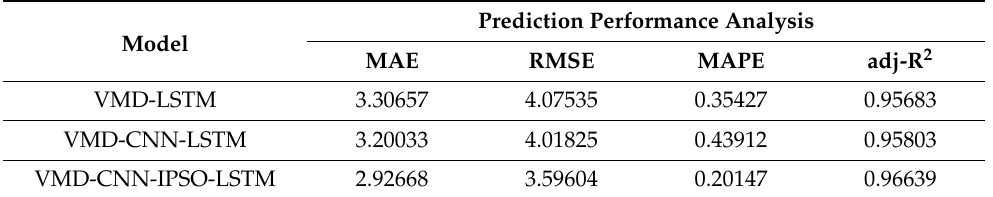
Table 7. Prediction performance analysis of each model in new data set.